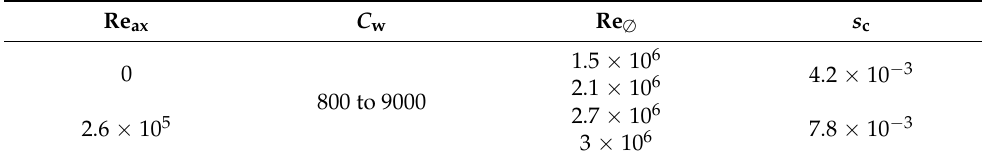
Table 1. Experimental test